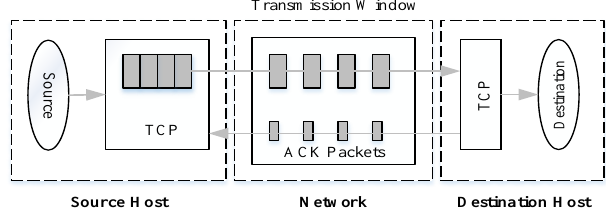
Figure 1. Models of TCP flow control